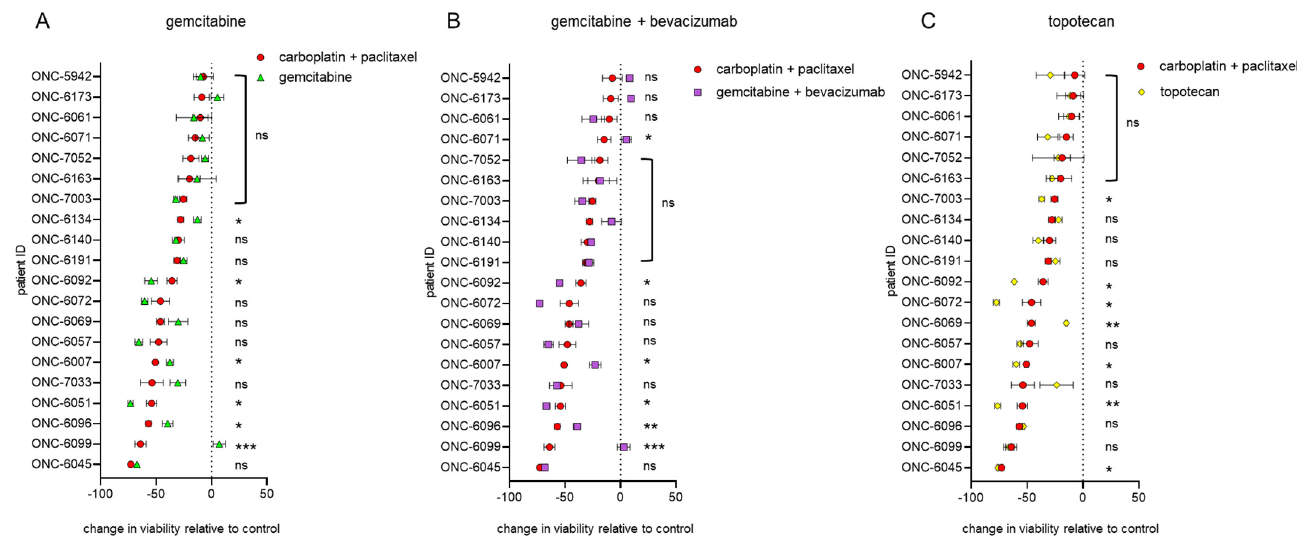
Figure 2. Therapeutic efficacy of common second-line therapies for endometrial and ovarian cancers using PDO models. Endometrial and ovarian cancer PDO response to second-line therapies: ( A ) gemcitabine, ( B ) gemcitabine + bevacizumab and ( C ) topotecan. PDO models were treated with the indicated agents for 72 h, followed by assessment of cell viability as in Figure 1. The data were calculated as the change in viability relative to the control, which was set at 100% (i.e., no cell death). Each panel includes response to the standard chemotherapy (carboplatin + paclitaxel, red circles) for comparison, and the samples are ordered based on increasing sensitivity to carboplatin + paclitaxel. Statistical significance was assessed by two-way ANOVA with the Greenhouse–Geisser correction and Tukey’s multiple comparison test. Significant differences vs. carboplatin + paclitaxel are annotated on each panel; ns: not significant; * p < 0.05; ** p < 0.01; *** p < 0.001. All the statistical comparisons are provided in Supplementary Table S2, including specific p -values and comparisons vs. the untreated control. Note that some cases have greater sensitivity to second-line treatments as compared to the standard chemotherapy, whereas others are more resistant. For example, ONC-6099 is relatively sensitive to chemotherapy but had no change in viability when exposed to gemcitabine (panel A).